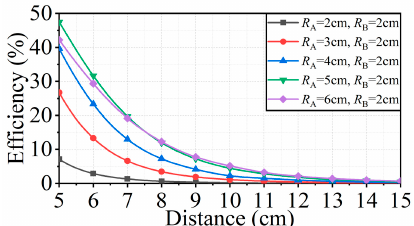
Figure 7. PTE curves with different values of R A .